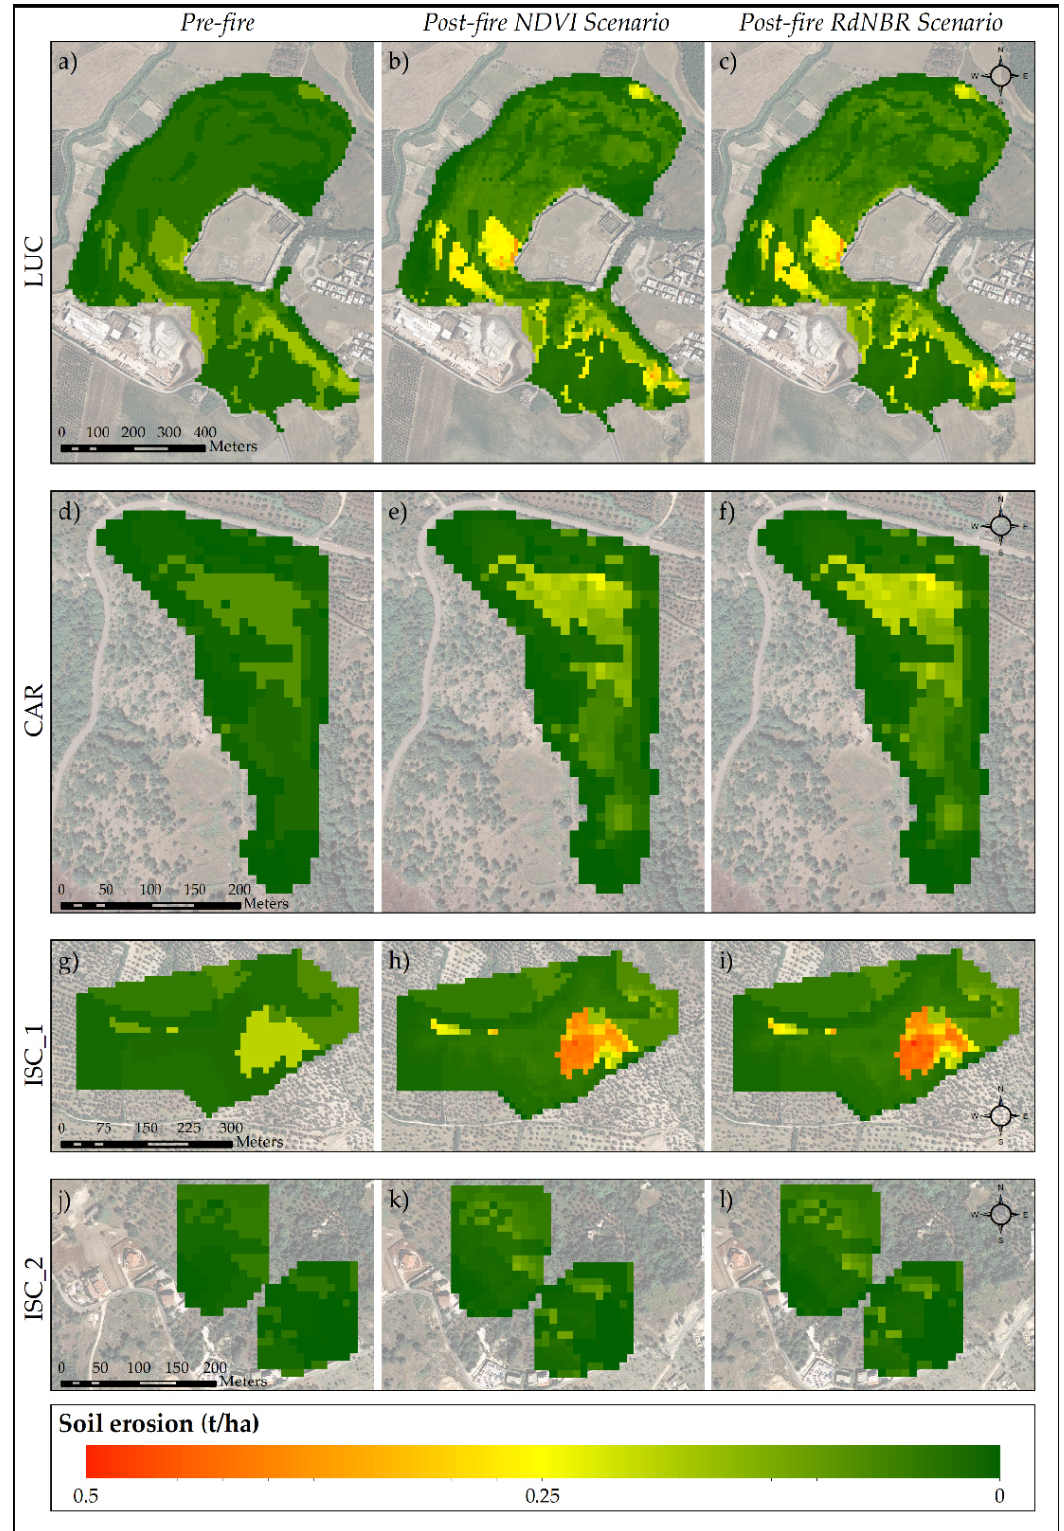
Figure 4. Pre-fire and post-fire erosion values (t/ha). LUC: ( a ) pre-fire, ( b ) post-fire Normalized Difference Vegetation Index (NDVI) scenario, ( c ) post-fire Relative differenced Normalized Burn Index (RdNBR) scenario; CAR: ( d ) pre-fire, ( e ) post-fire NDVI scenario, ( f ) post-fire RdNBR scenario; ISC_1: ( g ) pre-fire, ( h ) post-fire NDVI scenario, ( i ) post-fire RdNBR scenario; ISC_2: ( j ) pre-fire, ( k ) post-fire NDVI scenario, ( l ) post-fire RdNBR